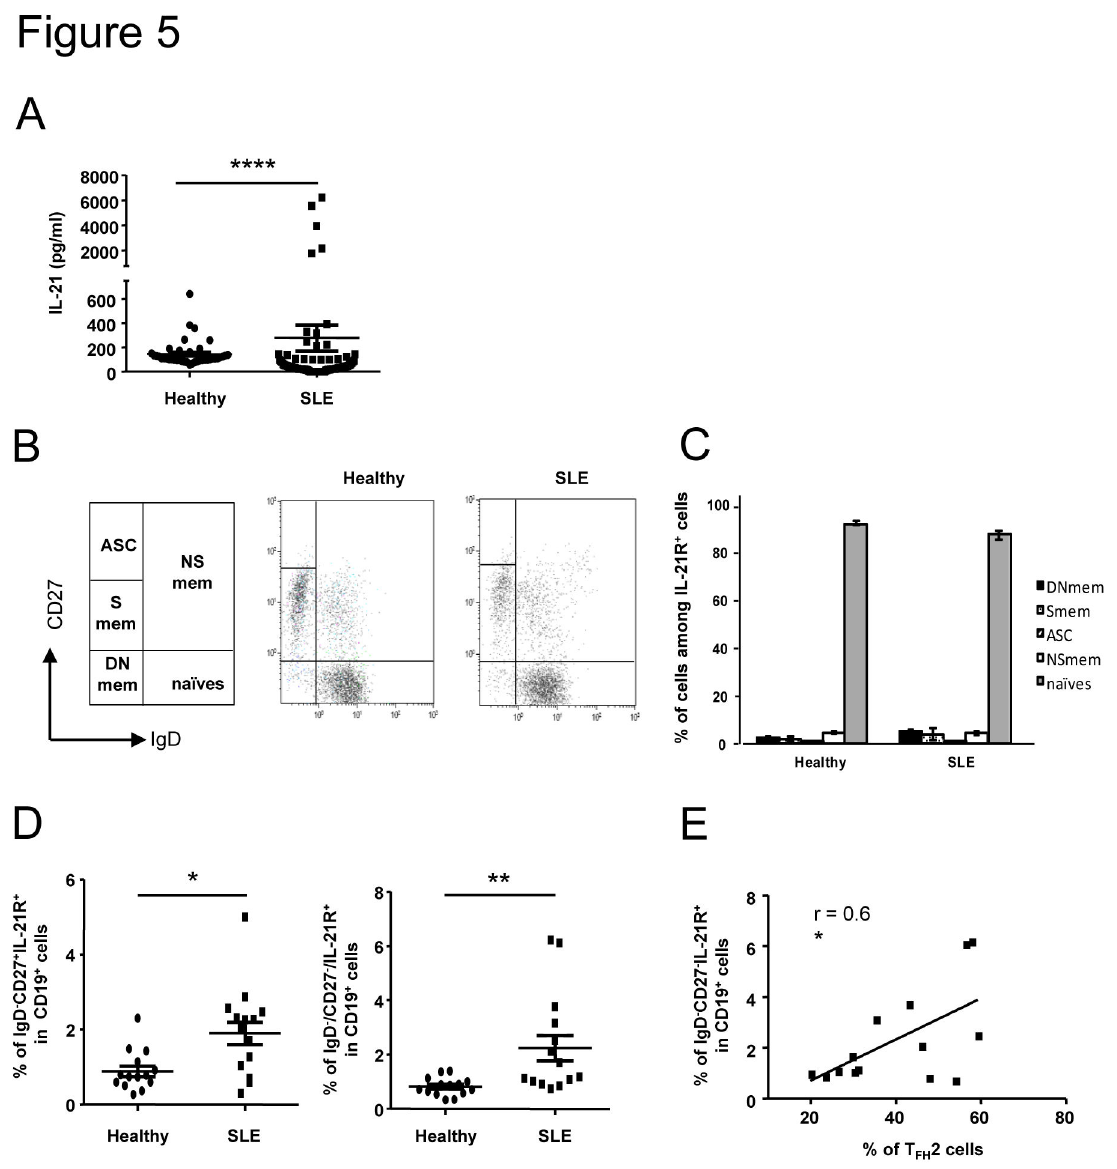
Figure 5. The frequency of memory B cells expressing IL-21R is enhanced in SLE patients and correlates with T 2 cell FH increase. IL-21 concentration was measured in the serum of SLE patients (n = 88) and healthy controls (n = 44) by a sandwich ELISA assay (A). Results are expressed as the mean IL-21 concentration (pg/ml) from duplicate wells. Each data point represents an individual subject and horizontal lines show the mean ± sem. Circulating B cell subsets were defined according to the expression of IgD and CD27 on CD19 + IL-21R + cells allowing the definition of 5 populations: Ab-secreting cells (ASC), non switched memory cells (NSmem), switched memory cells (Smem) and double negative memory cells (DNmem). Representative dot plots obtained with samples from one healthy control and one SLE patient are shown as an example (B). The distribution of each B cell subset among IL-21R + cells in healthy controls (n = 14) and SLE patients (n = 14) is represented (C). The frequency of CD27 + memory (left) and DN memory (right) B cells expressing IL-21R is compared between healthy controls (n = 14) and SLE patients (n = 14). Correlation between the IL-21R + DN memory cells and T 2 cell subset frequencies in SLE patients (n= 14) is represented (E). Each FH data point represents an individual subject; horizontal lines show the mean ± sem. * p < 0.05, ** p < 0.01 (Mann-Whitney U test and Pearson correlation coefficient).